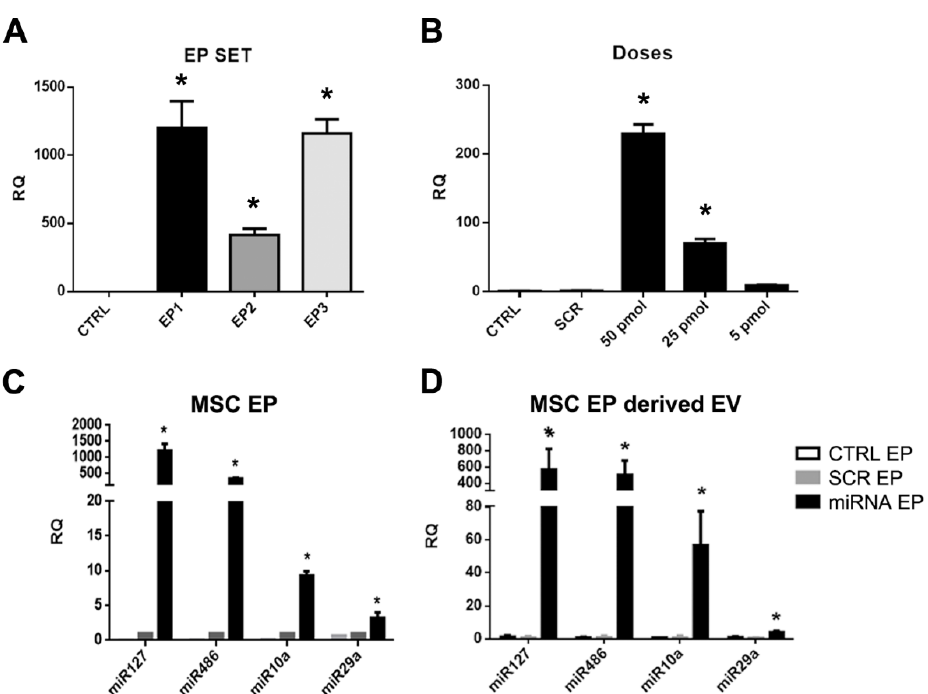
Figure 2. miRNA enrichment evaluation in mesenchymal stromal cells subjected to electroporation (MSC-EP) and derived EVs. ( A ) Representative real-time PCR showing the efficiency of transfection for different electroporation protocols (EP1-3). ANOVA with Dunnett’s multiple comparison test was performed. * p < 0.05 EP protocol vs CTRL (non elecroporated cells); ( B ) representative real-time PCR showing the efficiency of transfection for different doses of control miRNA mimic obtained with EP1 electroporation conditions. ANOVA with Dunnett’s multiple comparison test was performed. p < 0.05 different control miRNA doses vs scramble (SCR); ( C ) representative real-time PCR showing the increased expression of the selected miRNAs (miR10a, miR29a, miR127, miR486) 24 h after transfection in MSC-EP and ( D ) in derived EVs collected 24 h after transfection. Data were normalized in respect to MSC transfected with the SCR. Data are represented as relative quantification (RQ) ± SEM. * p < 0.05 MSC-EP SCR vs. MSC-EP transfected with mimics and * p < 0.05 EV-SCR vs. EV transfected with mimics. Multiple t test with Holm–Sidak method correction was performed.